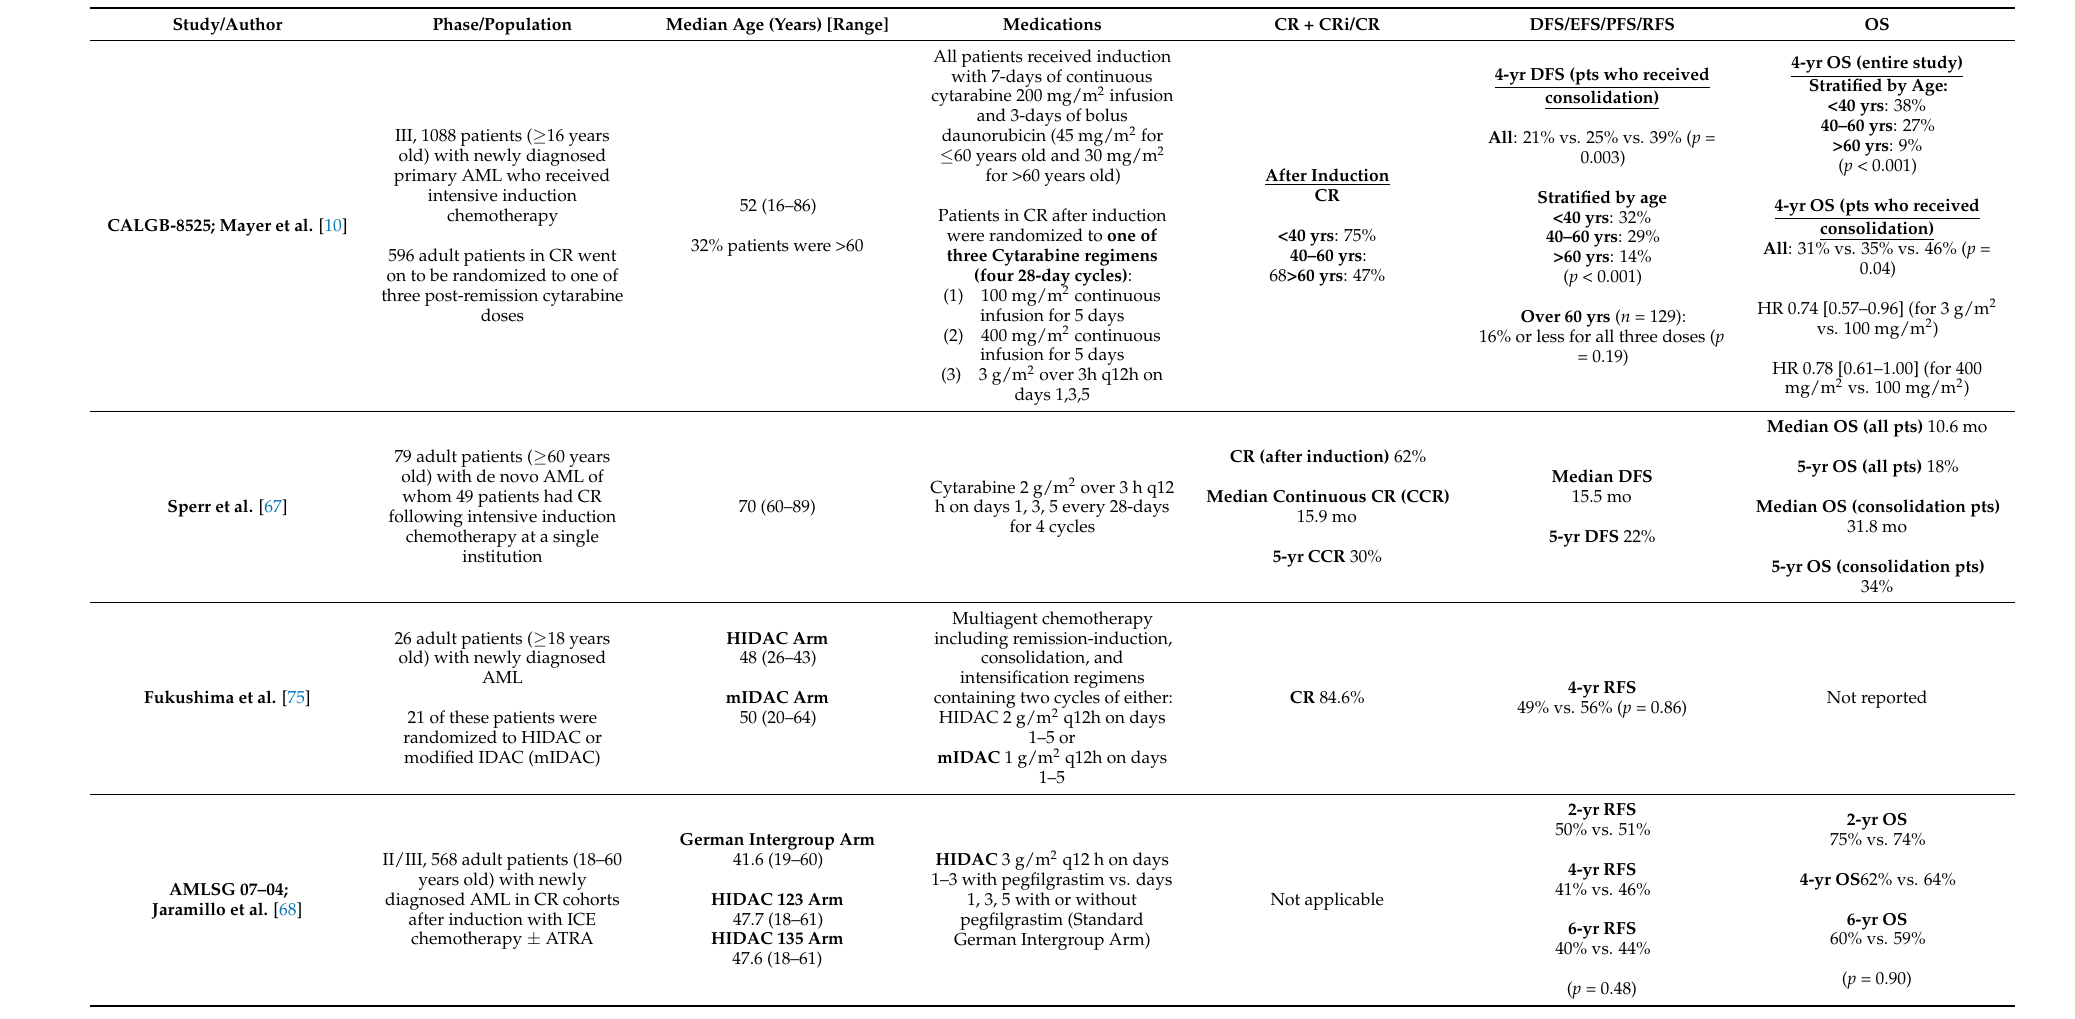
Table 4. Consolidation regimens for adults with AML with an emphasis on older